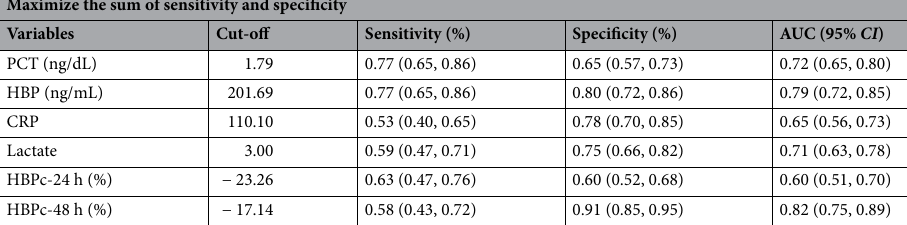
Table 3. Accuracy of different biomarkers in predicting 30-day mortality. AUC refers to the area under the ROC curves in which the larger AUC means higher discriminative capability. The cutoff was determined to maximize the sum of sensitivity and specificity. PCT, HBP, CRP and Lactate refer to their respective levels at baseline.